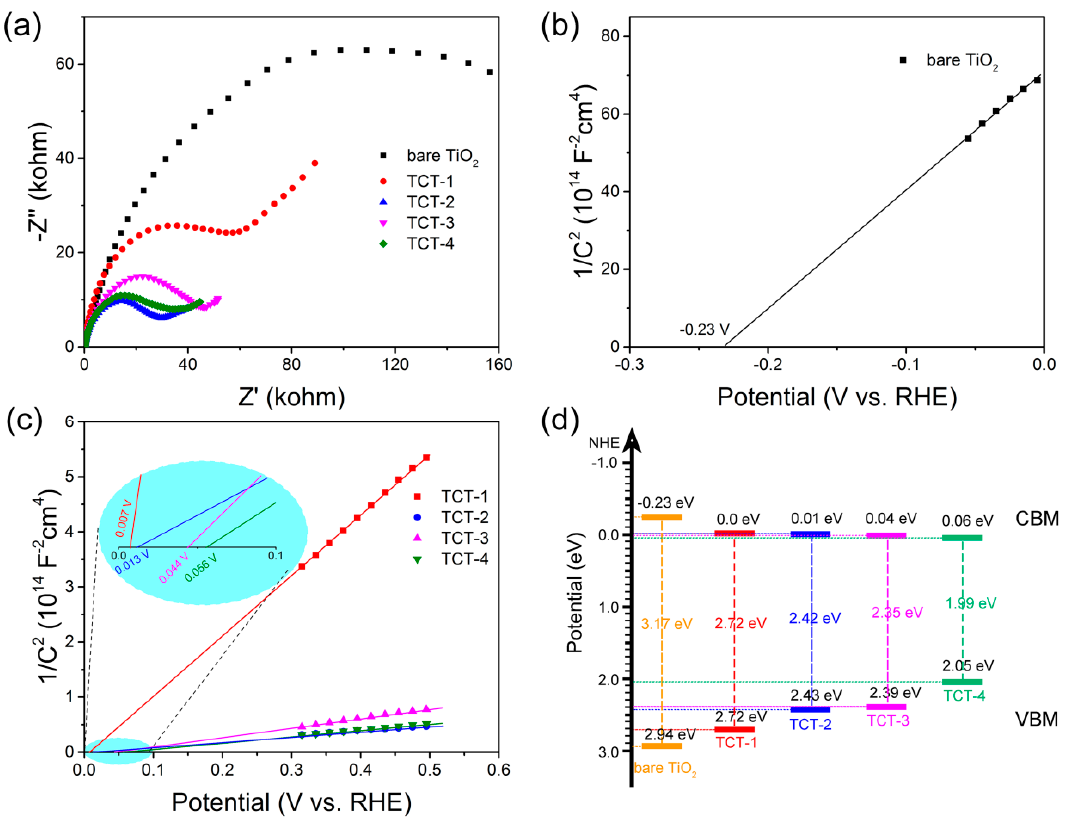
Figure 8. ( a ) EIS curves measured under light illumination; ( b , c ) Mott–Schottky plots of bare TiO 2 and four TCT photoanodes, respectively; and ( d ) band positions of all measured